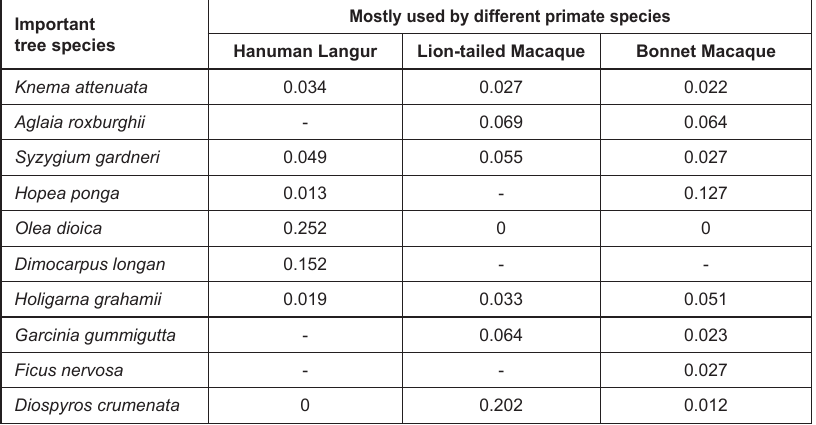
Table 3. Use of important tree species as major resources by different primates